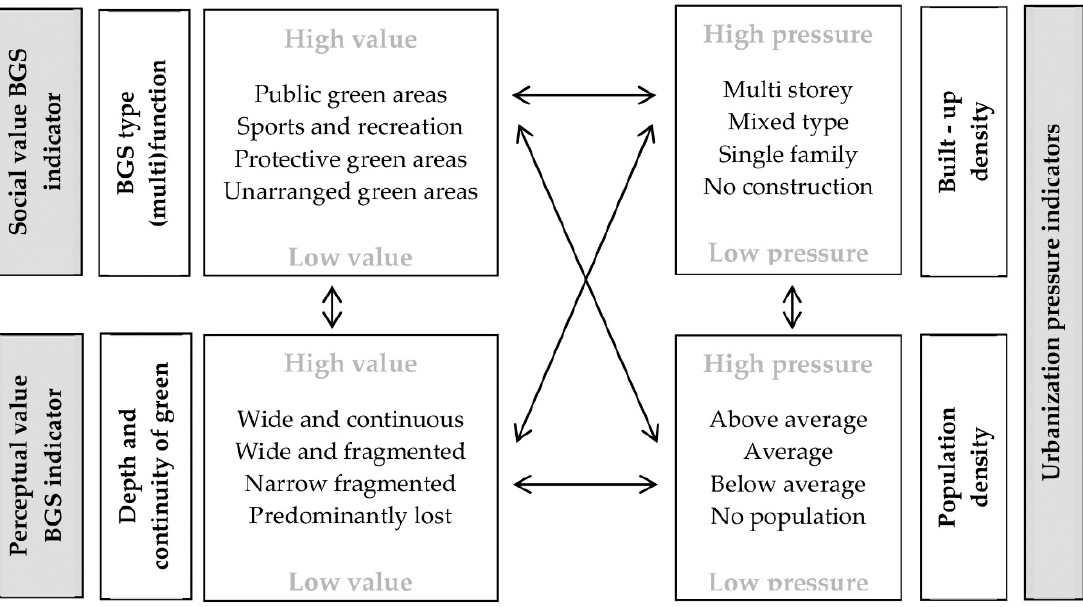
Figure 9. Interrelation and evaluation of urban blue and green space (BGS) criteria defining quali- tative change indicators relevant to urban